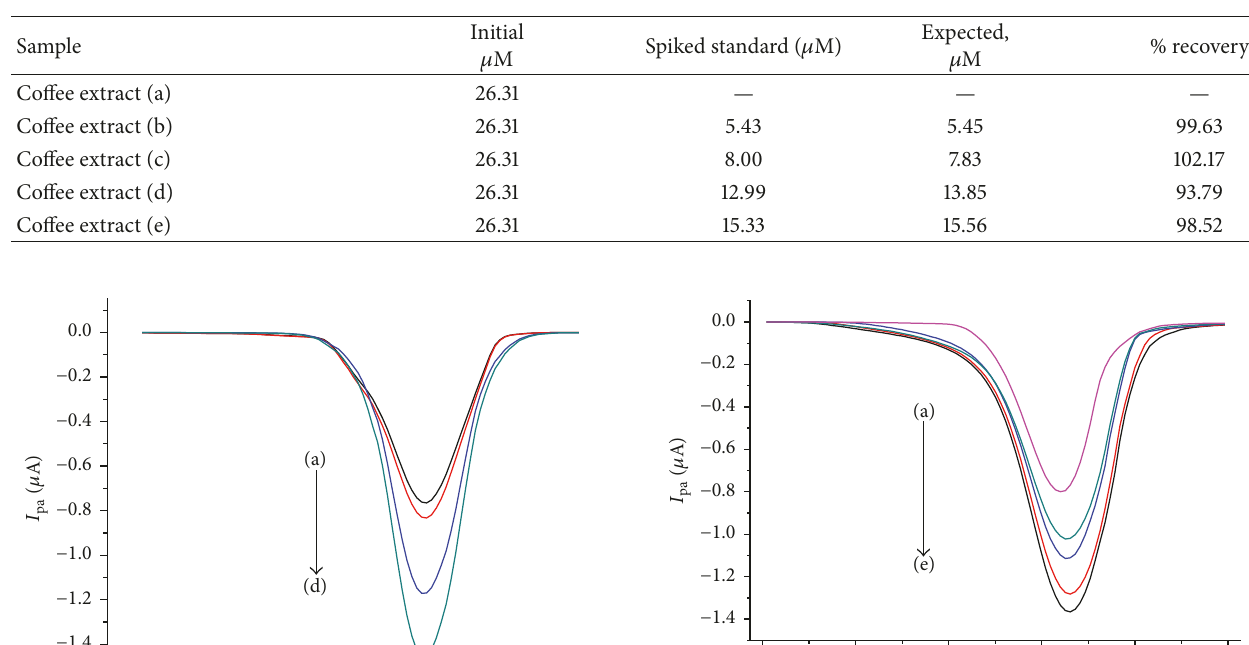
Table 2: Summary of percentage recoveries of spiked standard caffeine in aqueous coffee extract.